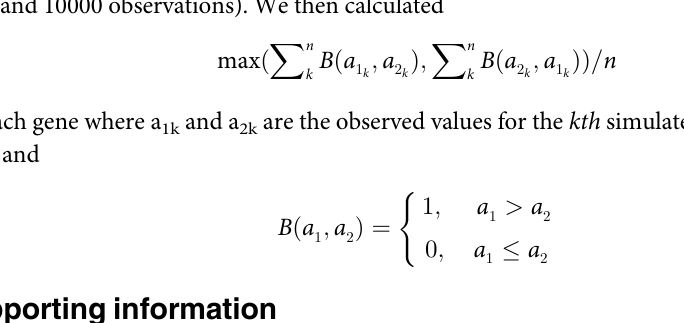
S1 Fig. Observed fraction of cells with allelic expression patterns compared against those predicted. Predicted fraction of cells with (A) biallelic, (B) no expression, monoallelic expres- sion from the (C) C57 and (D) CAST allele based on either the Poisson model (left) or the two-state model of transcription (right). S2 Fig. Theoretical dependence of bursting parameters on allelic expression patterns. The probabilities of having biallelic, monoallelic (from CAST or C57) or no detectable expression directly predicted from the two-state model of transcription. Inferred kinetics were used for each gene. Plotting the allelic expression patterns as a function of burst frequency (A) and burst size (B). Note, the results are almost identical to the dependencies observed in single-cell RNA-seq data (shown in Fig 2B and 2C). S3 Fig. Investigating the bursting parameter dependence on allelic expression patterns observed on cells in vivo . Analyses on the three largest cell type clusters observed in the sin- gle-cell RNA-seq analysis of the mouse skin. (top) T-cells (n = 4,299 genes and 83 cells), (mid- dle) Lower Hair Follicle cells (n = 5,807 genes and 75 cells), (bottom) Interfollicular Epidermal cells (n = 5,145 genes and 57 cells). Left panels show the relationship between inferred burst kinetics and allelic expression patterns. Right panels show the correlations between predicted and actual allelic expression patters, with spearman correlation coefficient in the bottom right corners. Note these patterns observed in cells in vivo are highly consistent with the analyses performed on cells in primary cultures. S4 Fig. Comparison of ubiquitously expressed and expression matched genes. Histogram and densities showing the ratio (Observed/Expected fraction biallelic expression) for ubiqui- tously expressed genes and random genes with matched total expression across cells. S5 Fig. Comparison of allelic biased expression to bursting parameters. (A) Histogram showing the distribution of P (C57 > CAST | C57 6¼ CAST, n = 7,606 genes). (B) Relationship between burst frequency and equal expression (which is dominated by no expression on either allele). S1 Table. Inferred transcriptional burst parameters for the C57 and CAST allele. k_on, k_off and k_syn are maximum likelihood estimates. bf_lower, bf_upper,bs_lower and bs_up- per are confidence intervals based on bootstrap estimates. bf_n and bs_n are the successful number of bootstrap attempts (out of